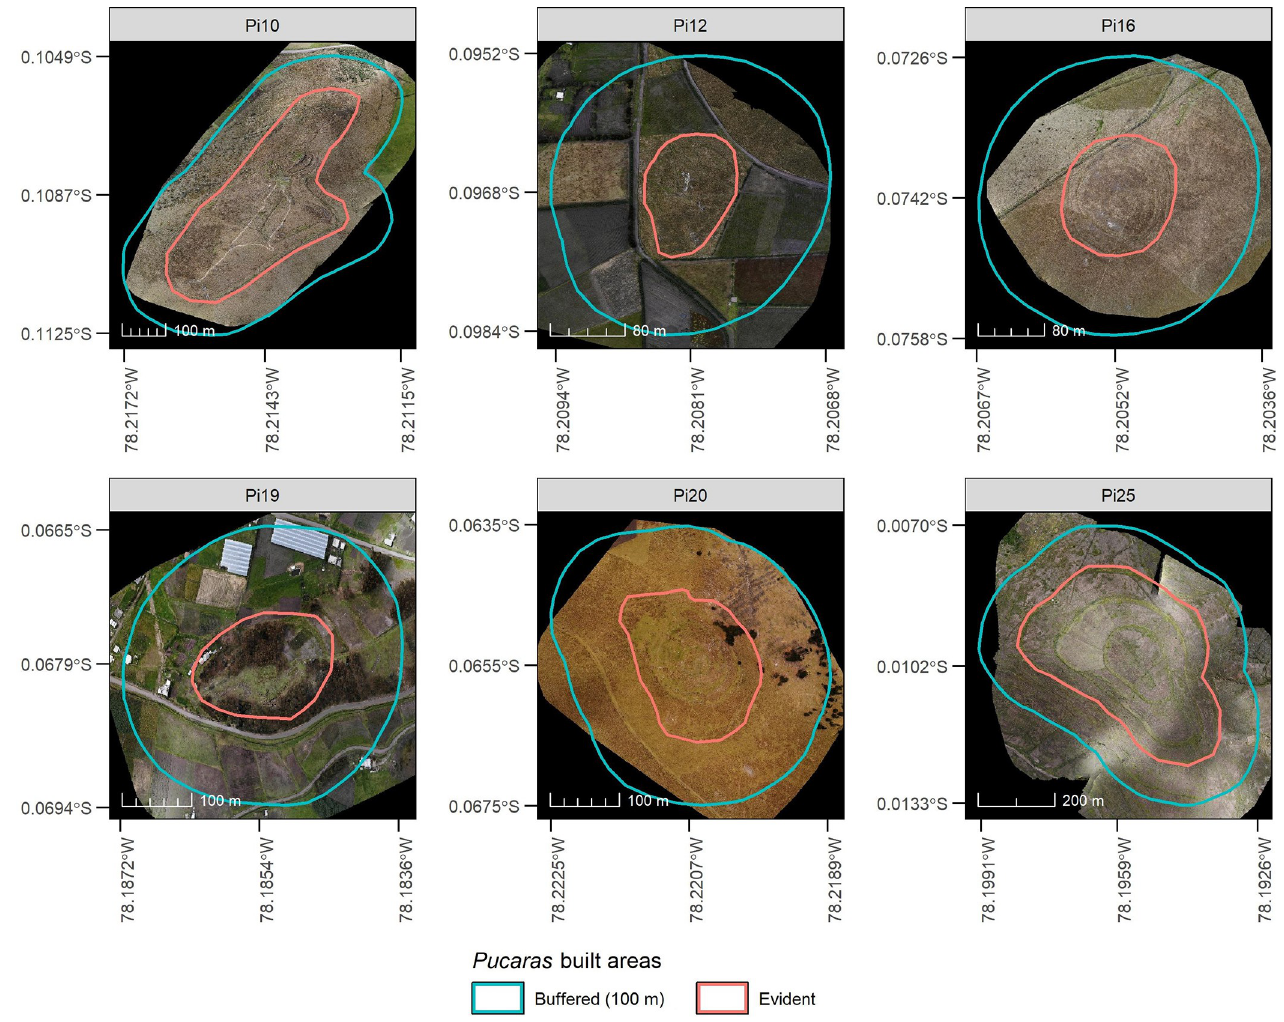
Fig 3. Pucaras orthophotos derived from the UAV flights campaigns.